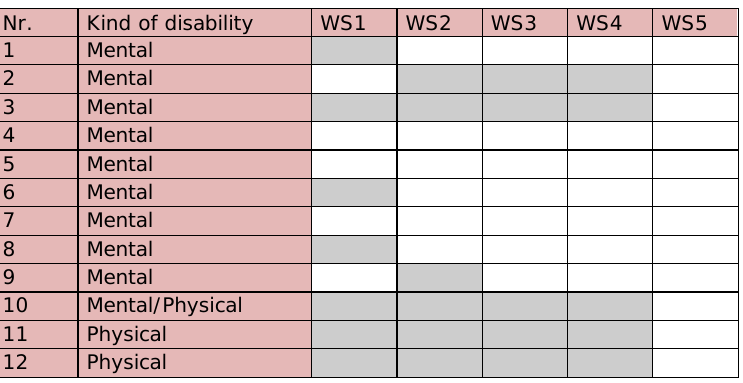
Table 1. Initial situation of the five workstations